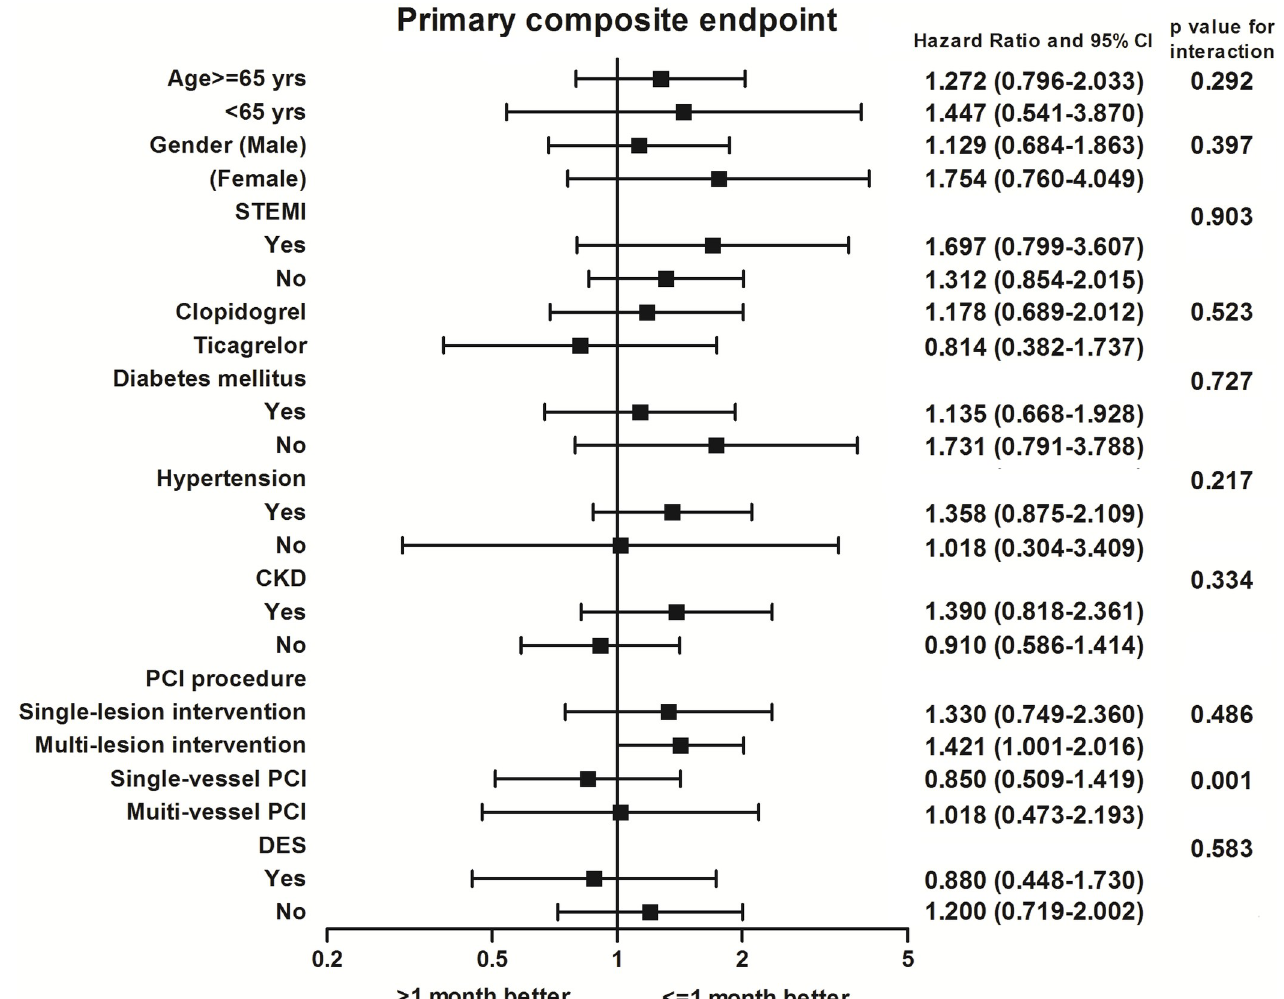
Fig 2. Subgroup analysis of the effect of different aspirin duration on primary composite